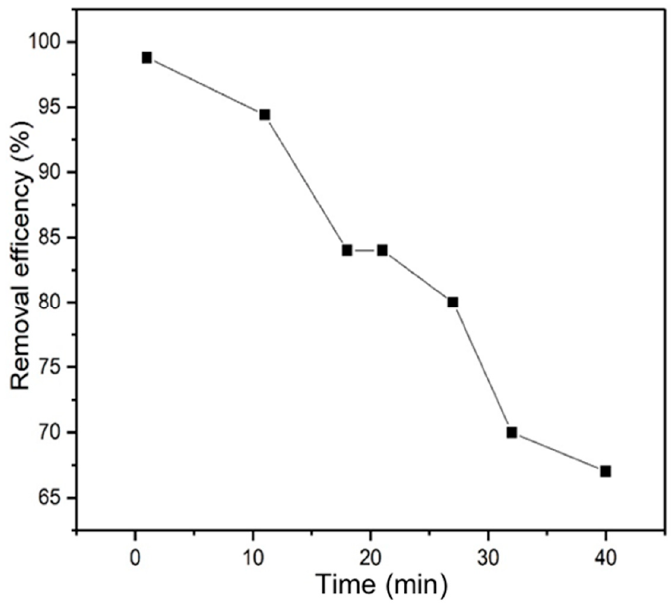
Figure 11. The Tl(I) removal efficiency using the freeze-dried NOCNF column test as a function of adsorption time.